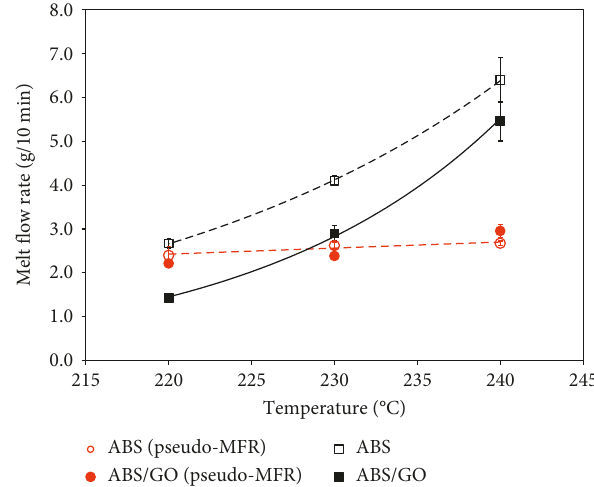
Figure 6: Melt flow rate (MFR) of the ABS filament and the ABS/GO composite filament dependent on temperature (220– 240 ° C). Black color represents the results from the conventional MRF measurement, and red represents the results from the pseudo-MFR measurement using the 3D printer.